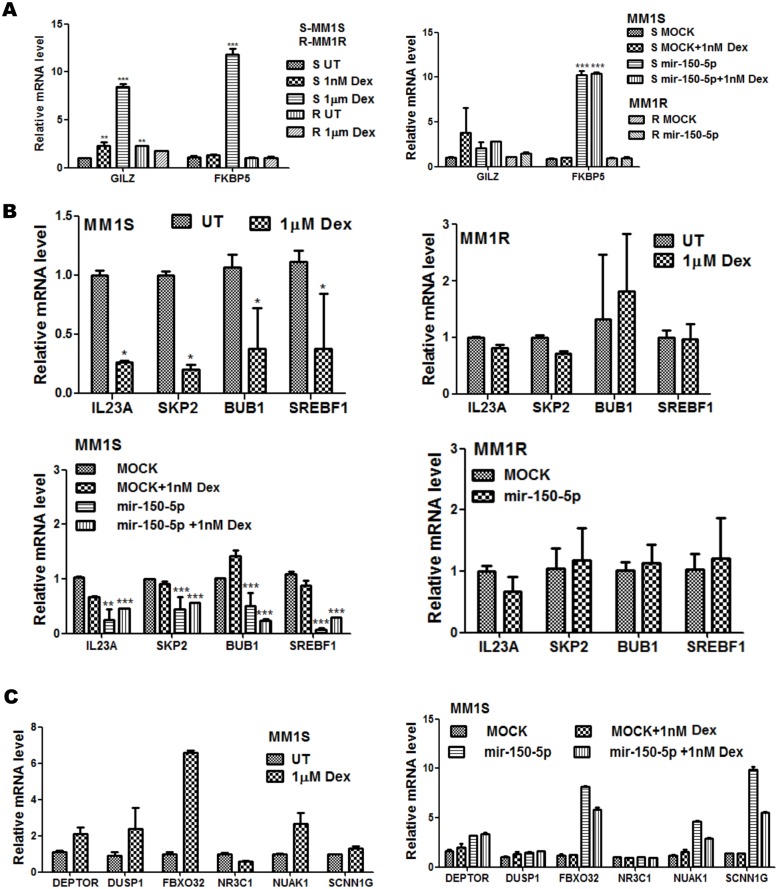
Mir-150-5p transfection mimics GR like gene activation and repression response in MM1S and lack of response in MM1R cells.(A) Realtime quantitative PCR (QPCR) validation of GILZ (TSC22D3) and FKBP5 mRNA induction in MM1S and in MM1R cells, following 72 h treatment with 1 nM or 1 µM Dex (left panel), or following 72 h transfection with synthetic mir-150-5p, 72 h treatment with 1 nM Dex, or a combination thereof (right panel). Data represent (mean ± SEM) values of three independent experiments normalized to 28S RNA housekeeping gene and relative to the respective untreated/solvent (UT) or MOCK control setups. Means with ***, **, * are significantly different (p<0.001, <0.01 or <0.05) from control setup as determined by two-way ANOVA (Bonferroni posttest). (B) Realtime quantitative PCR (QPCR) validation of MYB, IL23A, SKP2, BUB1, SREBF1 mRNA repression levels in MM1S or MM1R cells, following 72 h treatment with 1 nM or 1 µM Dex, or following 72 h transfection with synthetic mir-150-5p, 72 h treatment with 1 nM Dex, or a combination thereof. Data represent (mean ± SEM) values of three independent experiments normalized to 28S RNA housekeeping gene and relative to the respective untreated/solvent (UT) or MOCK control setups. Means with ***, **, * are significantly different (p<0.001, <0.01 or <0.05) from control setup as determined by two-way ANOVA (Bonferroni posttests) (C) Illumina BeadChip Gene Expression Array results of selected genes are presented as bargraphs, reflecting mean of gene expression fold change from three independent experiments of MM1S cells, treated for 72 h with 1 µM Dex, or else of MM1S cells transfected for 72 h with synthetic mir-150-5p versus mock transfection, treated for 72 h with 1 nM Dex or a combination thereof versus control samples.